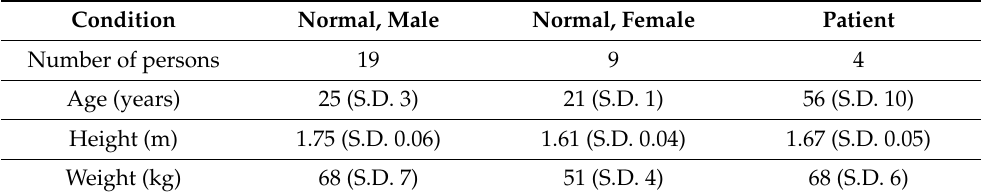
Table 1. Participant